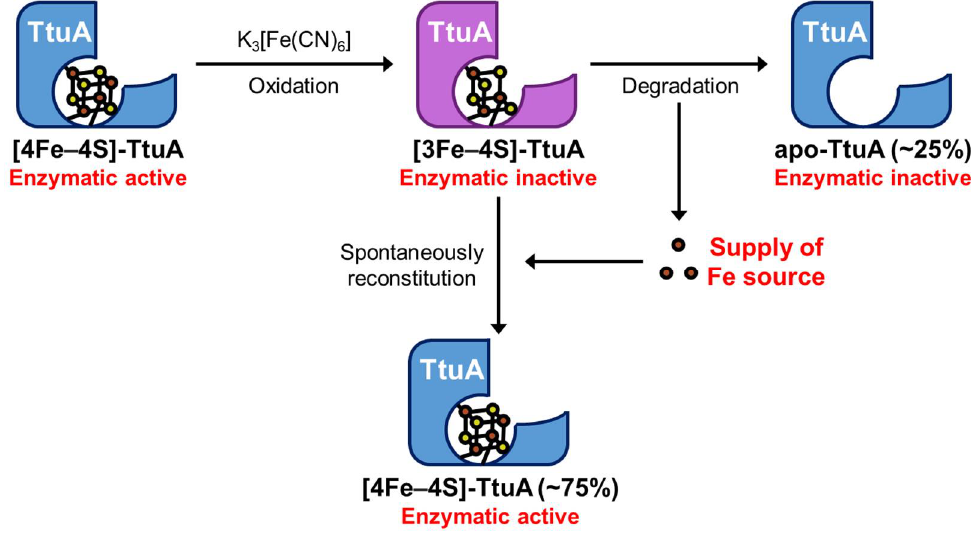
Figure 4. Schematic diagram of the proposed changes of the Fe–S cluster bound to TtuA.